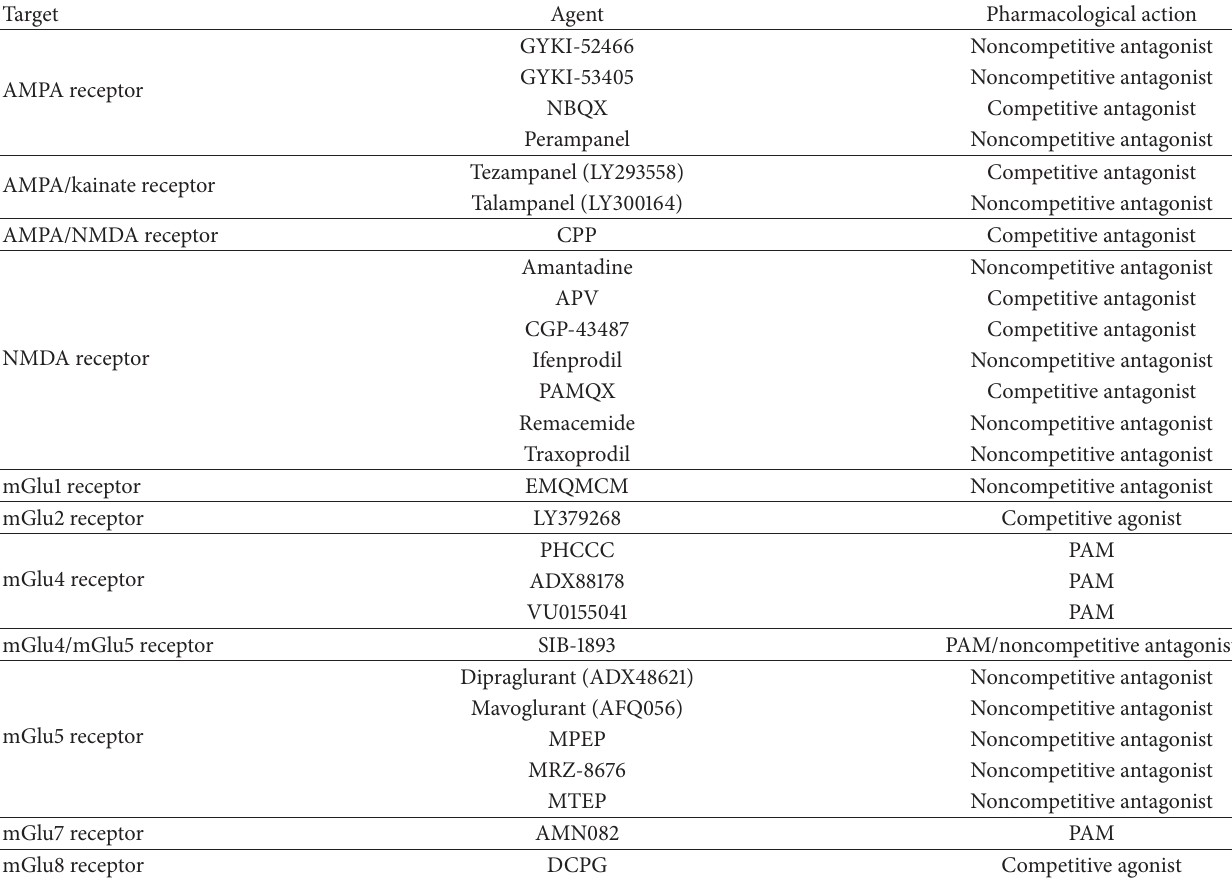
Table 1: Glutamatergic agents cited within the text with their pharmacological profile, main target/s, and mode of